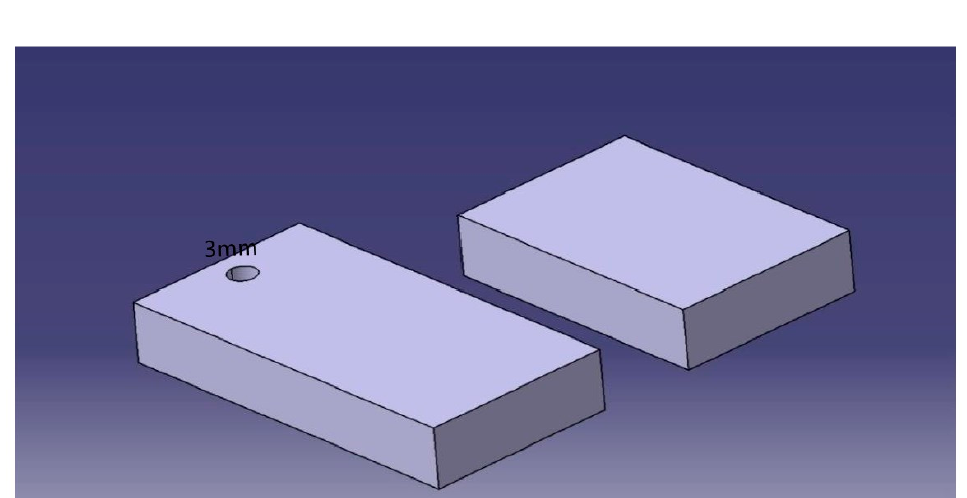
Figure 3. Bionic specimens with different distance distributions.